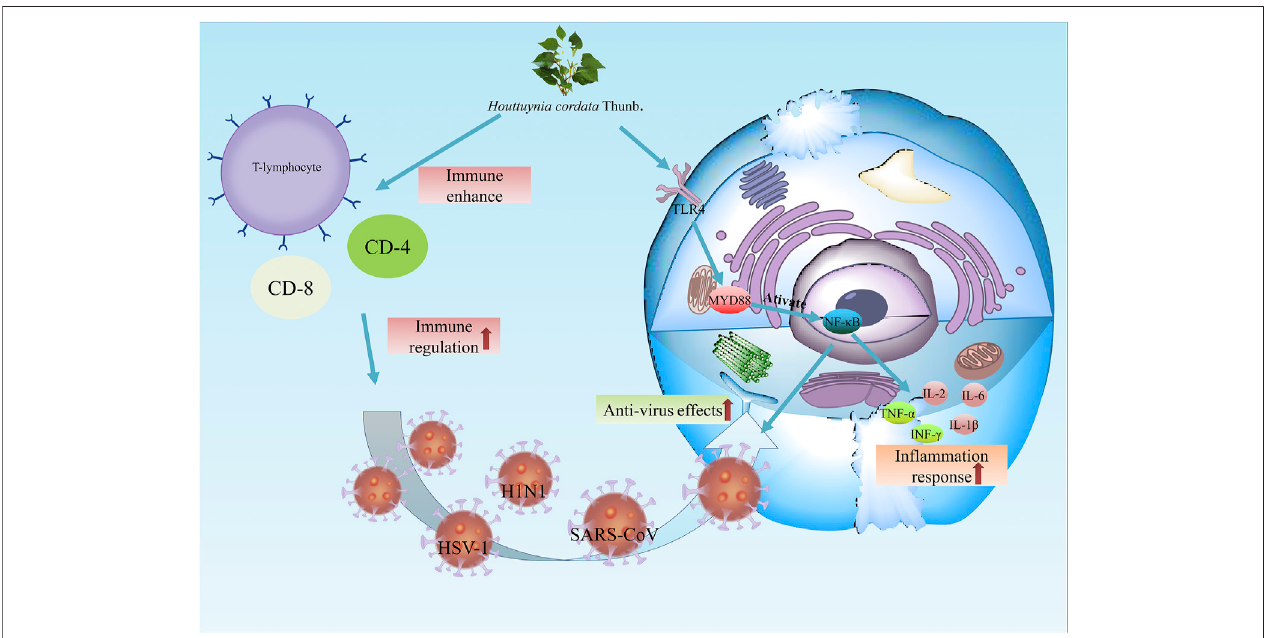
FIGURE5| Theantiviraleffectsof H.cordata .Ontheonehand, H.cordata enhancesimmuneactivitybyactivatingTcells,CD4 + cellsandCD8 + .Ontheotherhand, H. cordata combats viruses such as H1N1, HSV-1 and SARS-CoV by upregulating TLR4/NF- κ B signalling.